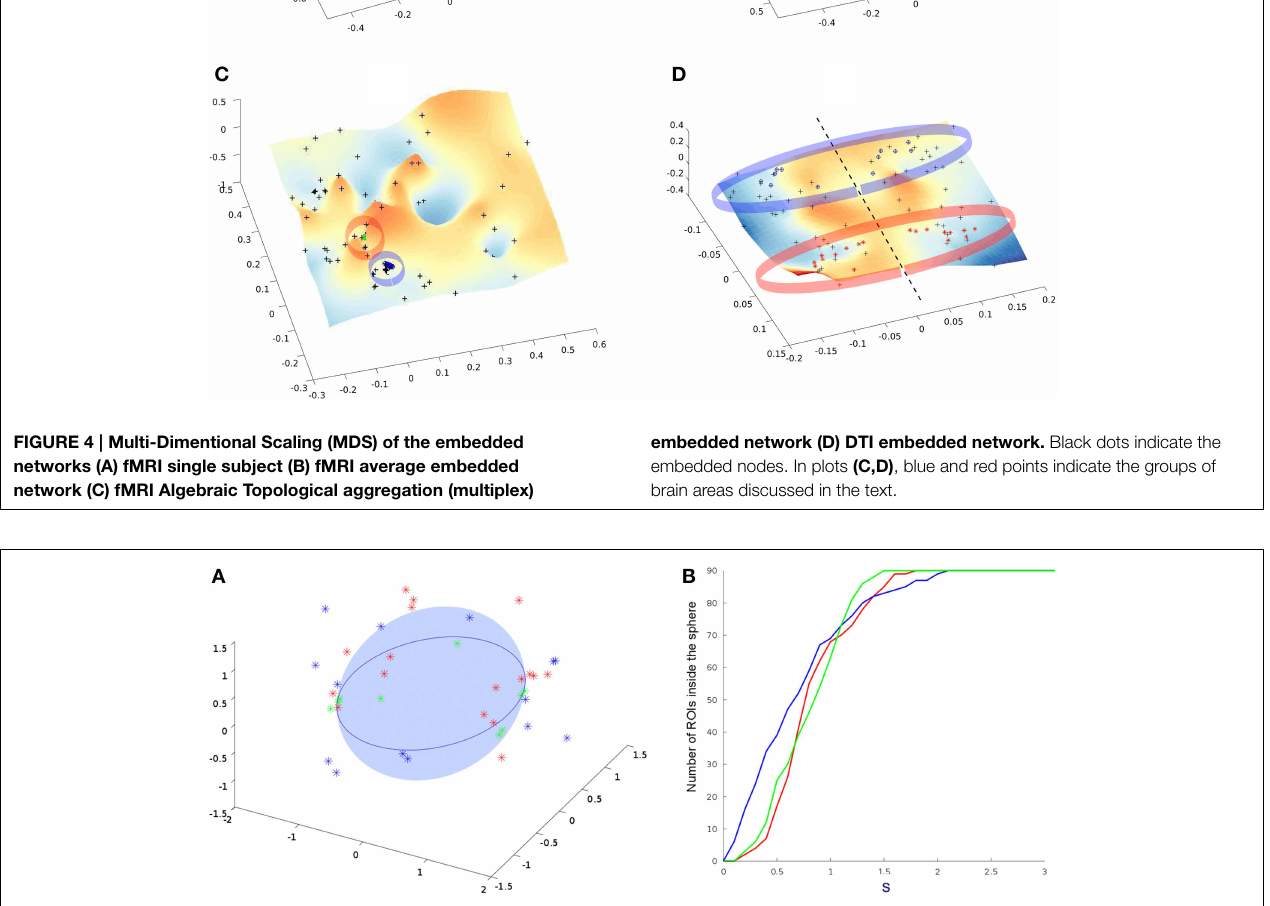
and green points and curves, respectively. We consider the regions statistically different for s > 1 and statistically equal for s < 1 . This shows that the multiplex algebraic aggregation (green) is more similar algebraically to DTI then average aggregation (blue) and single subject fMRI network